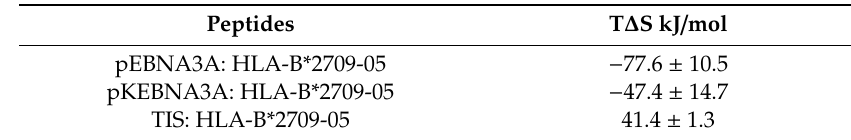
Table 2. Peptide entropy di ff erences.